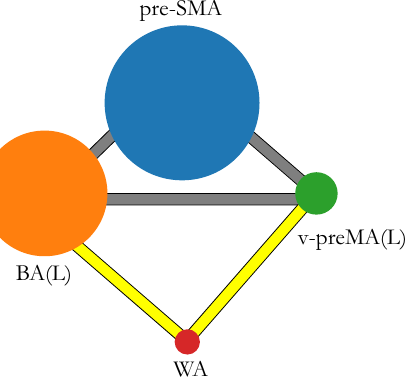
Figure 3. Common network structure in fROI level. The colored nodes represent fROIs, and their size is proportional to the averaged size of fROIs across all subjects. The solid gray links connecting pre-SMA, BA(L), and v-preMA(L), is the “ (cid:31) structure,” and the yellow links connecting WA(L) to BA(L) and to v-preMA(L), respectively, is the “ structure”. We use different colors for the links to distinguish their different frequencies (cid:31) ( f i ) of activation (activate in # of subjects/the total # of subjects). This information is provided as in Table 1: the “ (cid:31) structure” was activated in all studied subjects. The “ structure” was activated in all subjects in the bilingual (cid:31) Spanish-speaking group; this is different from monolingual group and bilingual English-speaking group, which only activated 75% and 50% of the time, respectively.